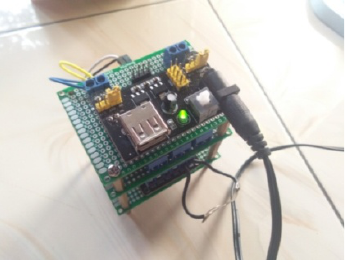
Figure 13. Testing Breadboard Power Supply